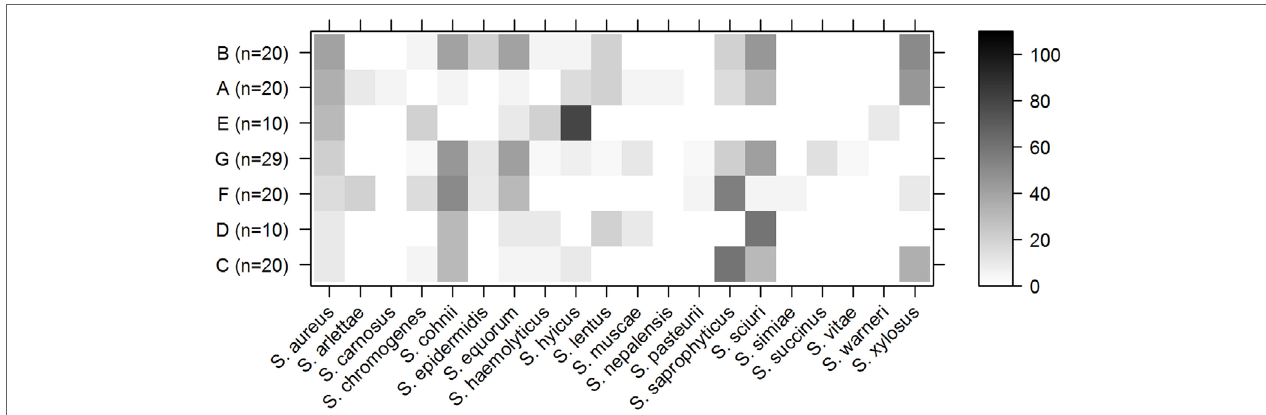
FigUre 2 | Staphylococci in pig lineages. Percentage of samples per lineage from which a specified staphylococcal species was isolated by culture. Rows indicate the different pig lineages with the total number of samples from this lineage between brackets. The columns contain different staphylococcal species. The shading of the cell represents the percentage of samples from that lineage that contained this species (right bar shows scale). Pig lineages are sorted by percentage of S. aureus -positive samples (first